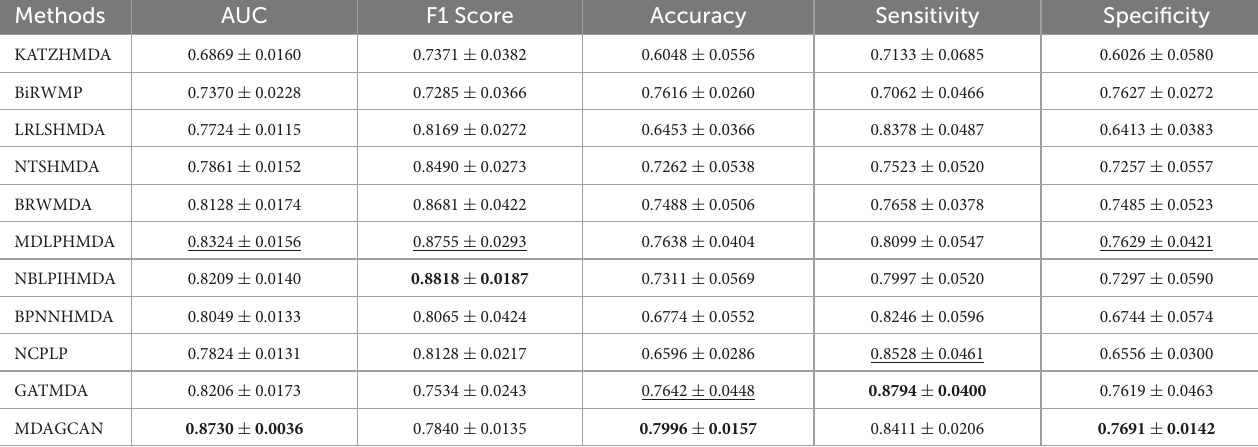
TABLE 4 Performance comparison between 10 baseline methods and MDAGCAN in 5-fold CV on MASI dataset.